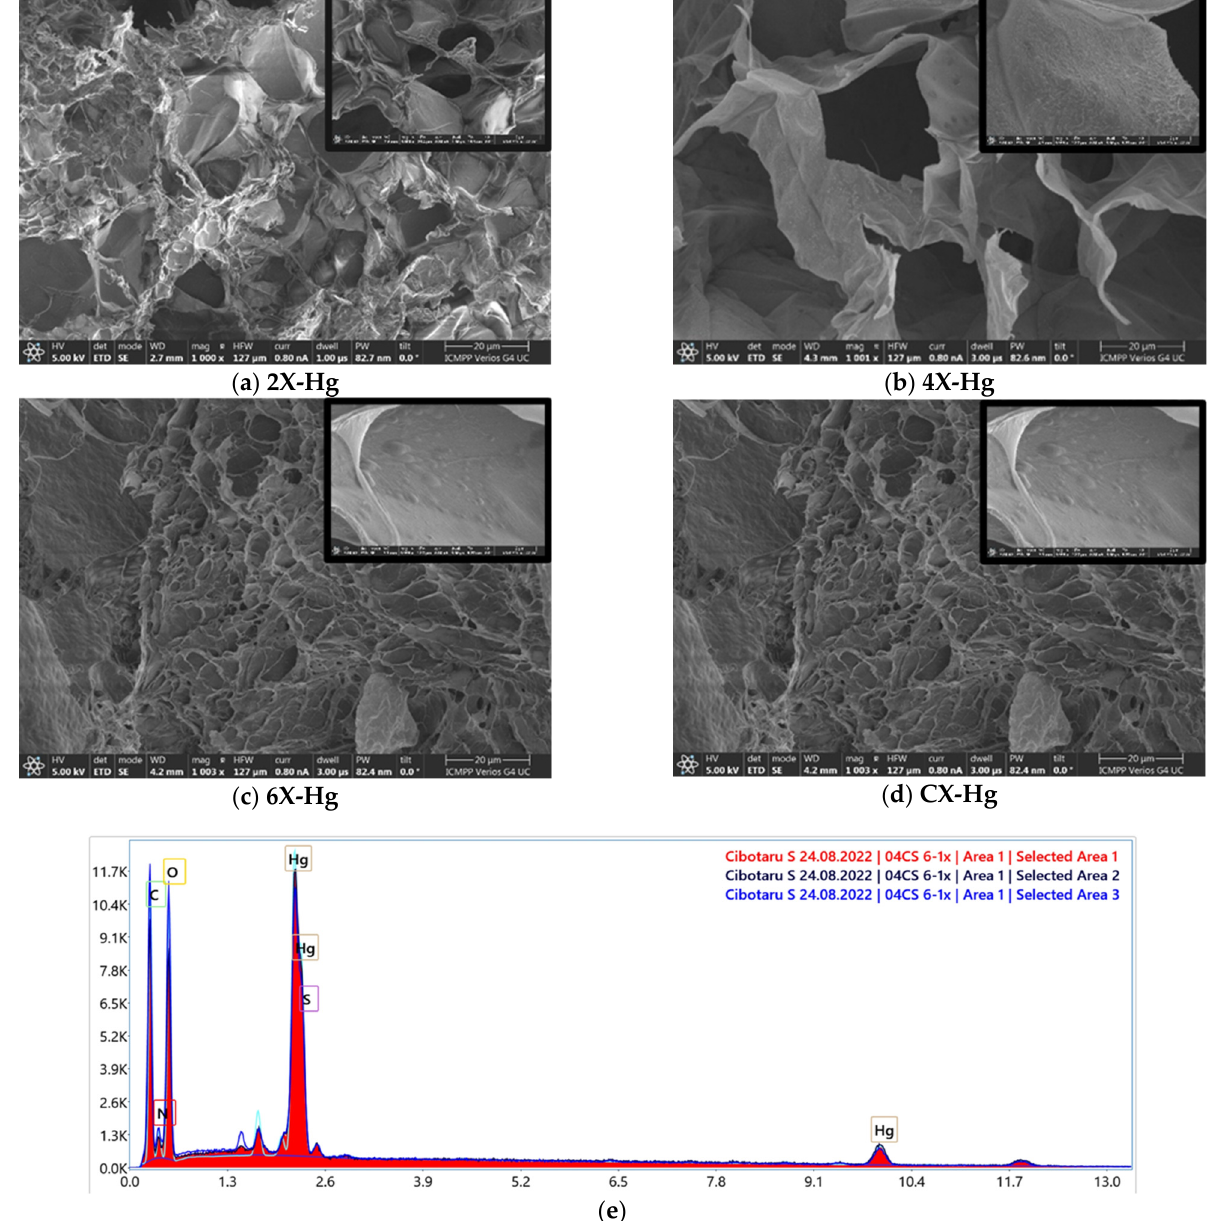
Figure 9. ( a – d ) SEM images of the xerogels at the end of the mercury recovery experiment and ( e ) ( e ) SEM-EDAX spectrum of SEM-EDAX spectrum of 6X-Hg.